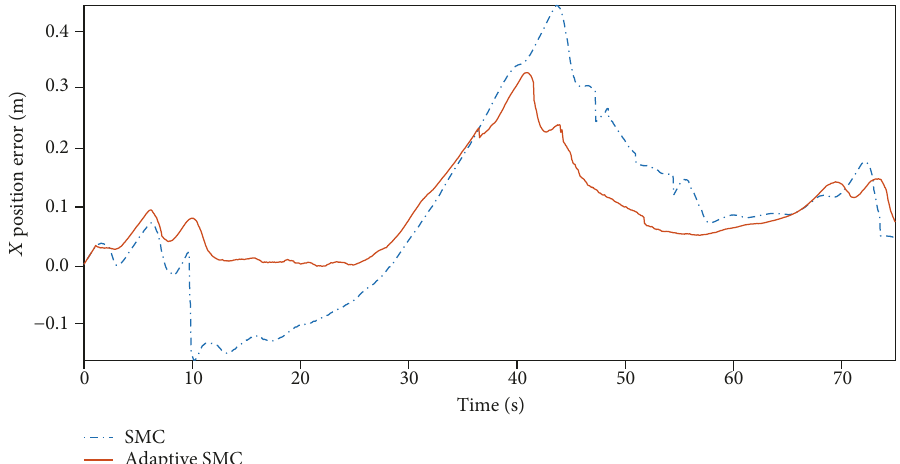
Figure 15: The comparison of errors in X -direction with